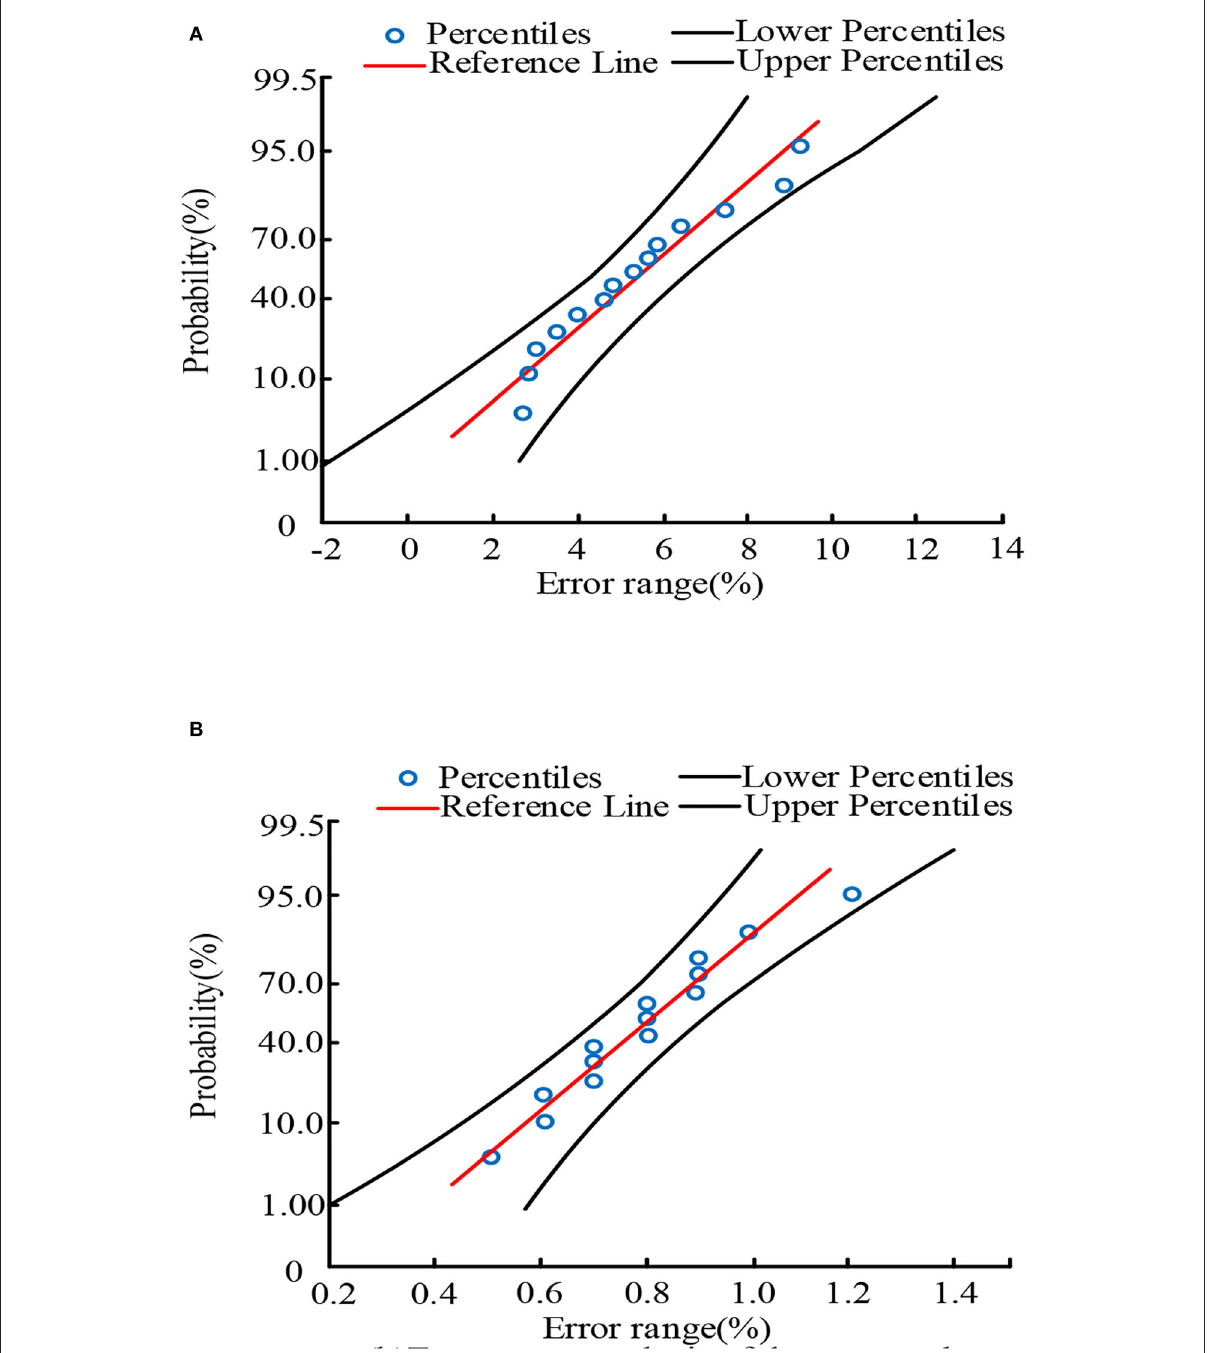
FIGURE6 Error comparison between Im-HMS system and UCD system. (A) Error range analysis of the existing UCD system. (B) Error range analysis of the proposed Intelligent m-Health monitoring system